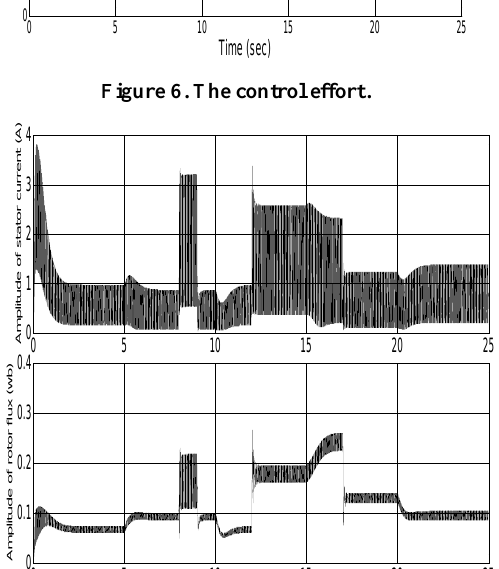
Figure 4. Dashed circle of the Figure 3 is zoomed.